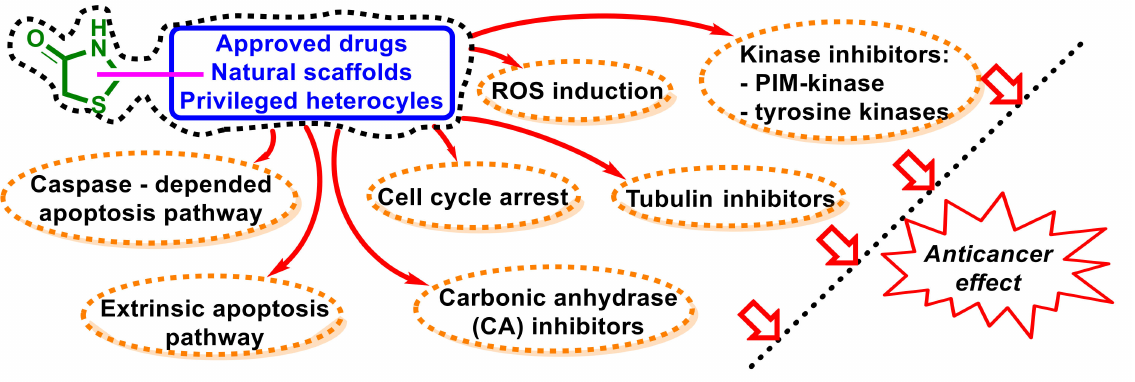
Figure 30. Schematic presentation of mechanisms of action and molecular targets for 4-thiazolidinone- bearing hybrid molecules with anticancer